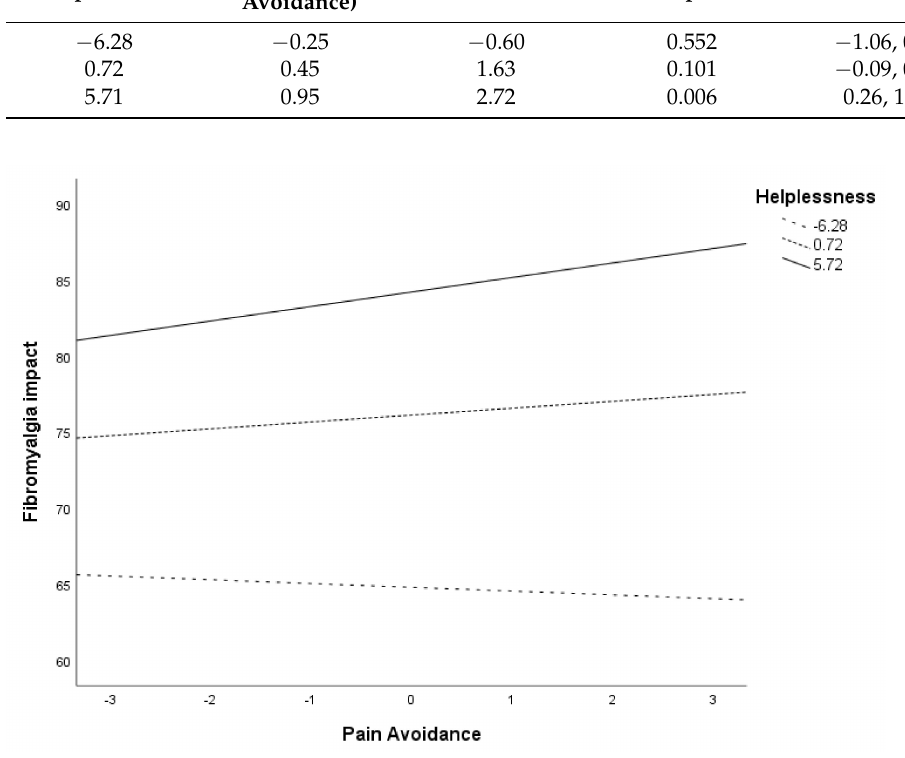
Figure 1. Conditional effects of pain avoidance on fibromyalgia impact at different values of